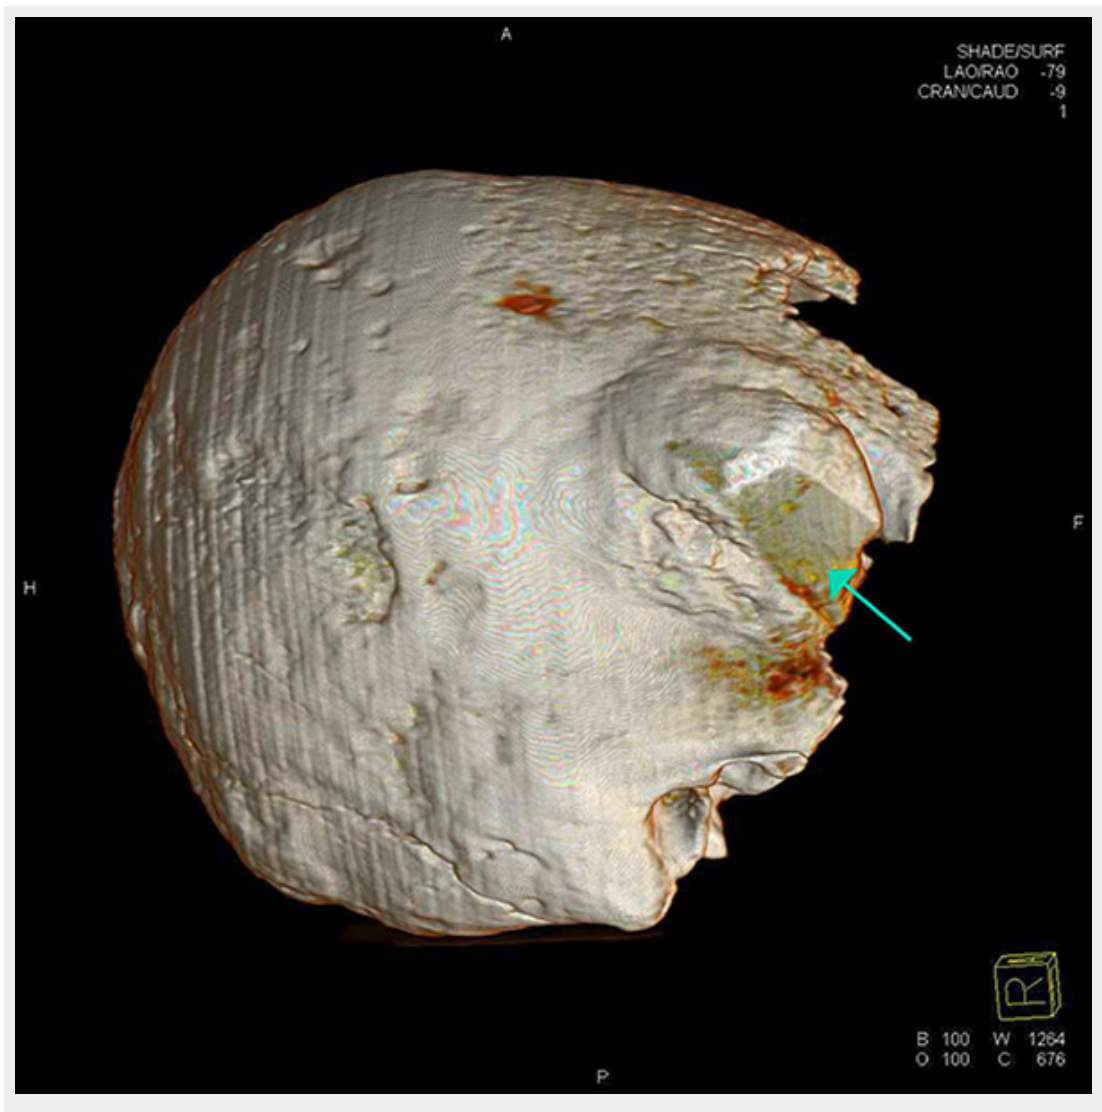
Figure 6 Computed tomography three-dimensional reconstruction of the skull. Wedge-shaped area in the centre of the lesion filled with material of lower X-ray density than the adjacent bone (green